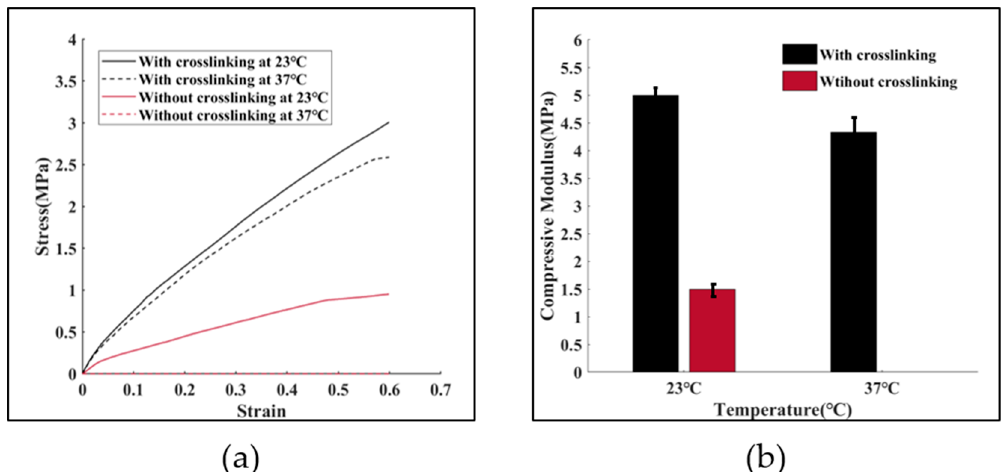
Figure 10. Compressive testing. ( a ) stress-strain curves of the samples with or without crosslinking at 23 °C and 37 °C respectively; and ( b ) compressive modulus of the samples with or without crosslinking at 23 °C and 37 °C respectively.